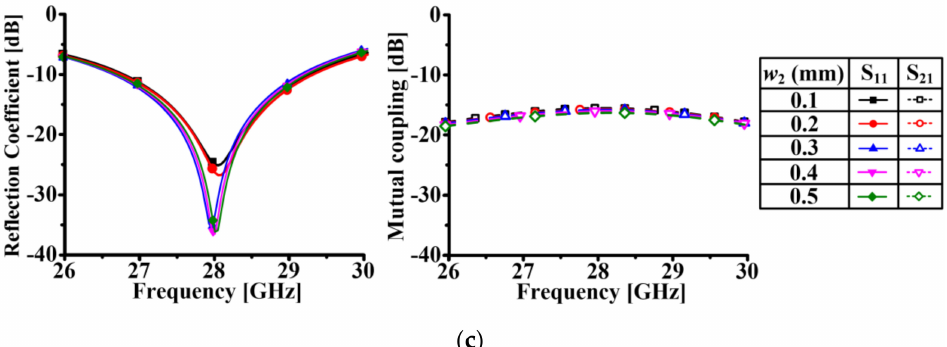
Figure 5. Parameter studies of the dimension of Slit 2 (dimension of Slit 1 is fixed): ( a ) antenna structure with Slit 1 and Slit 2, ( b ) simulated results of the reflection coe ffi cient and mutual coupling with various lengths ( h 2 ) of Slit 2 ( w 2 is fixed at 0.3 mm), and ( c ) simulated results of the reflection coe ffi cient and mutual coupling with various widths ( w 2 ) of Slit 2 ( h 2 is fixed at 0.6 mm).